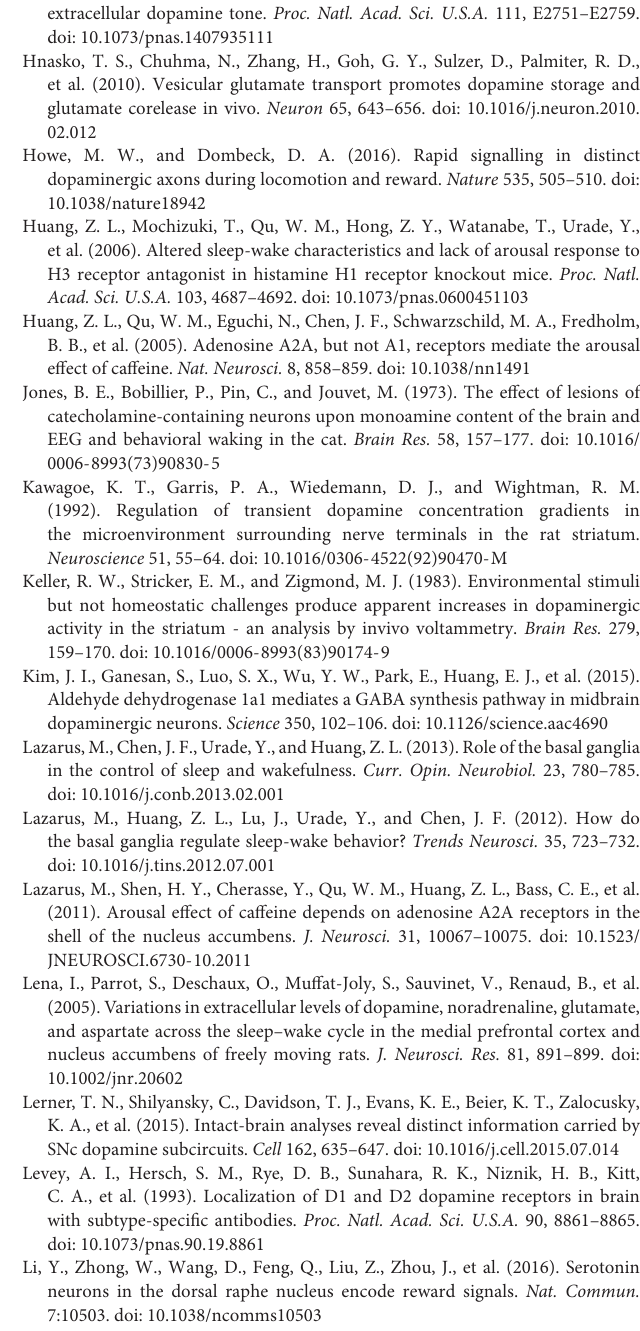
FIGURE S3 | The distributions of dLight fluorescence values in each state. The red presents REM sleep, the blue for NREM sleep, and the green for wake. The fluorescence in REM sleep was more divergent, but more convergent in NREM sleep. There was 3.14% dLight fluorescence values in REM sleep higher than 0.1, 10.26% values higher than 0.05, 71.48% values lower than 0, and 7.51% values lower than − 0.1, whereas there was 0.57% dLight fluorescence values in NREM sleep higher than 0.1, 4.42% values higher than 0.05, 62.18% values lower than 0, 0.04% values lower − 0.1. Although it looks more higher in REM sleep because there a few higher values, the mean of dLight fluorescence was the lowest in REM